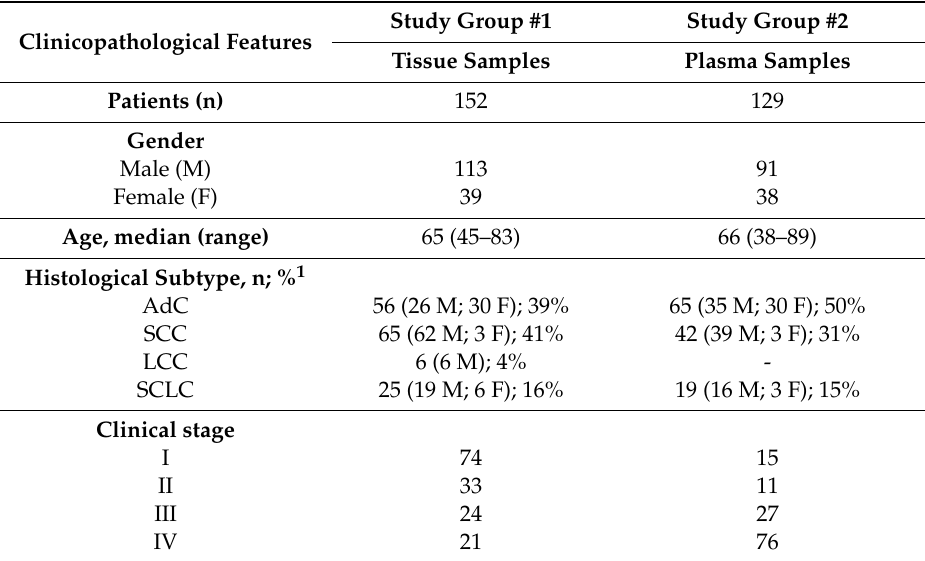
Table 1. Clinicopathological features of lung cancer (LCa) patients from study groups #1 and #2.